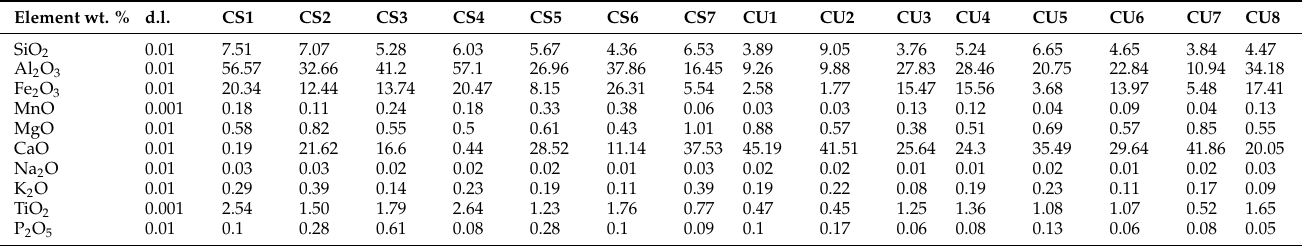
Table 1. Major (wt.%) and trace elements (ppm) in the Vitulano bauxite samples. Element wt. %